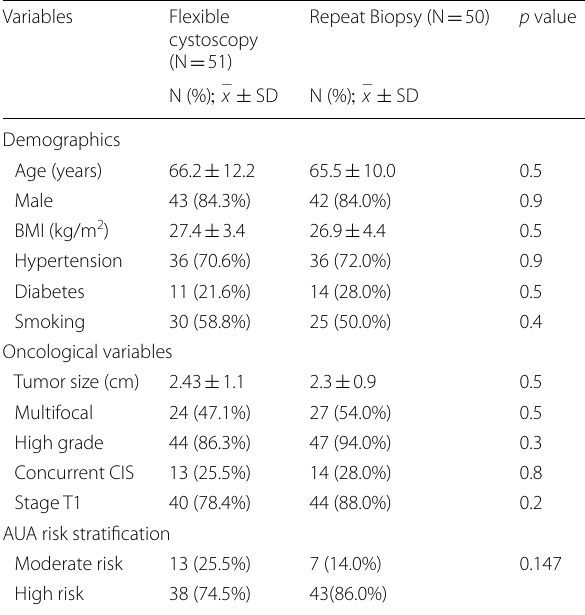
patients who underwent either flexible cystoscopy or cystoscopy with repeat biopsies for non‑muscle invasive bladder cancer